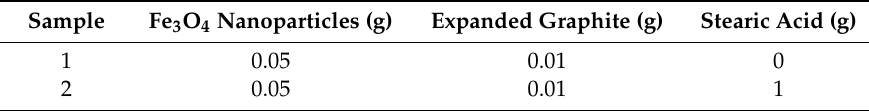
Figure 1. Schematic preparation of magnetic and hydrophobic composite polyurethane sponge. Table 1. The specific masses of magnetic Fe 3 O 4 nanoparticles, expanded graphite, and stearic acid for different sponge samples.